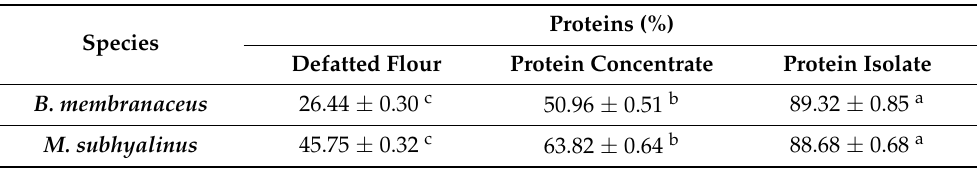
Table 4. Protein contents (%) of defatted flour, concentrates and isolates of Brachytrupes membranaceus and Macrotermes subhyalinus